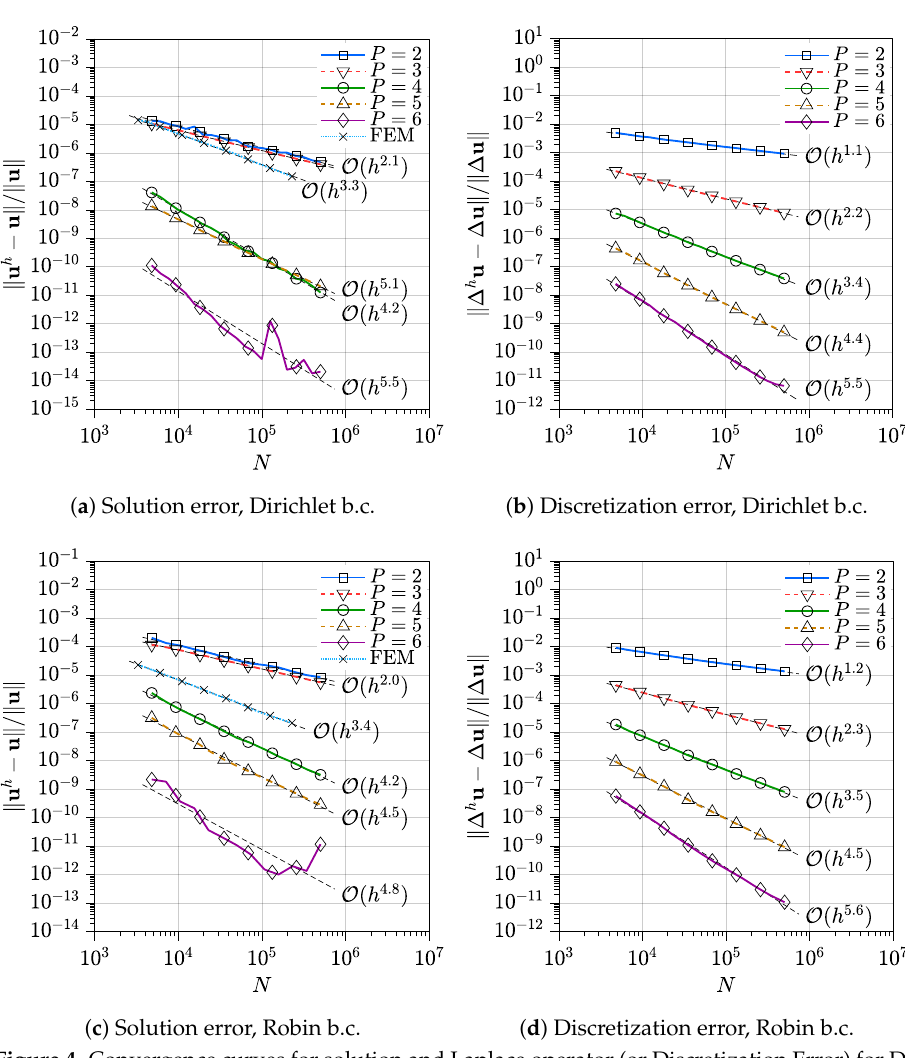
Figure 4. Convergence curves for solution and Laplace operator (or Discretization Error) for Dirichlet and Robin b.c., Ω :